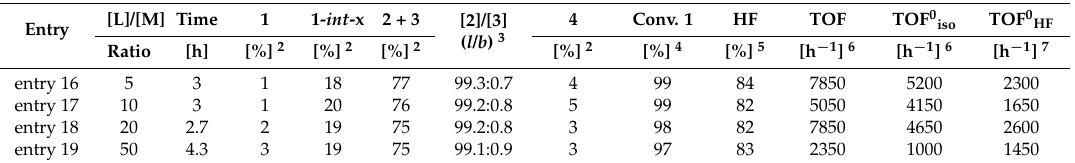
Table 4. Influence of the [biphephos]/[Rh] ratio on tandem isomerization-hydroformylation of 10-undecenitrile at [ 1 ] 0 /[Rh] = 3000 1 .